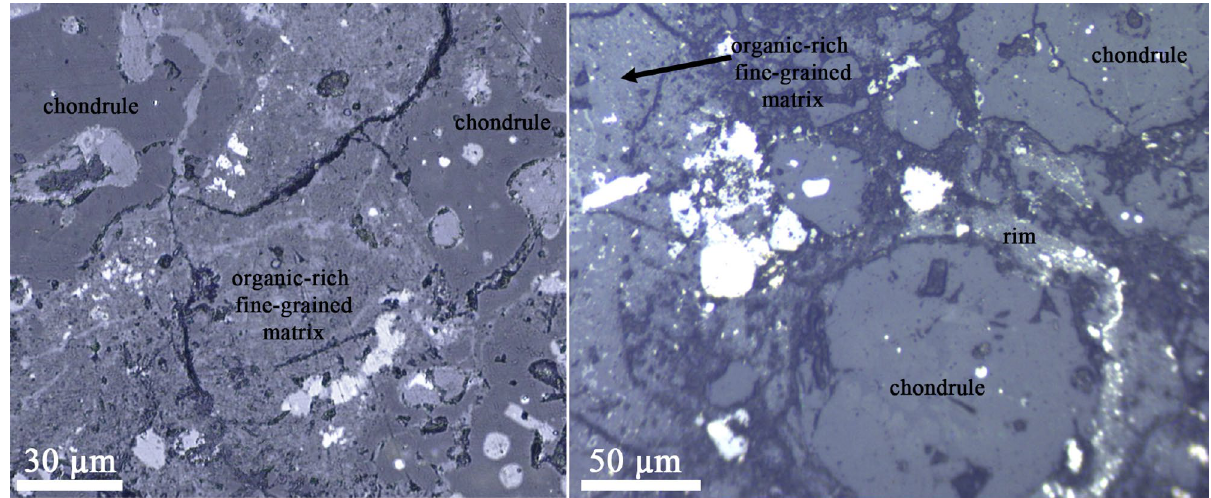
Figure 1. Reflected light visible micrographs of DOM 08006. The images show organic-rich fine-grained materials as well as rimmed chondrules. Opaque phases appear as bright objects.